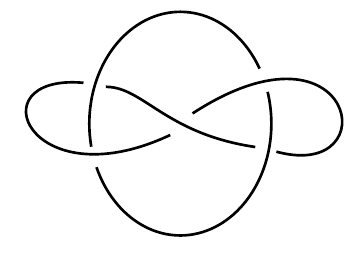
Figure 9 . The Whitehead link.